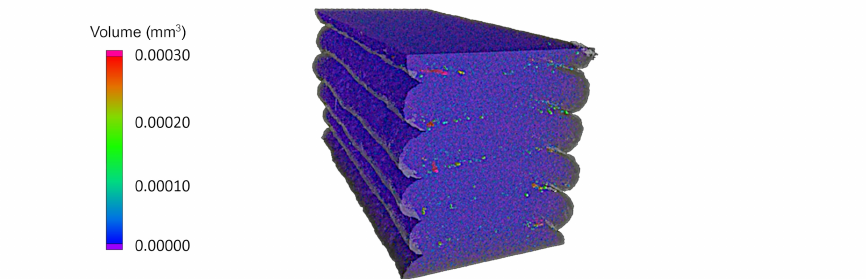
Figure 3. Three-dimensional view of the pores of a single-strand specimen at a substrate temperature of 170 °C and a layer height of 0.8 mm.